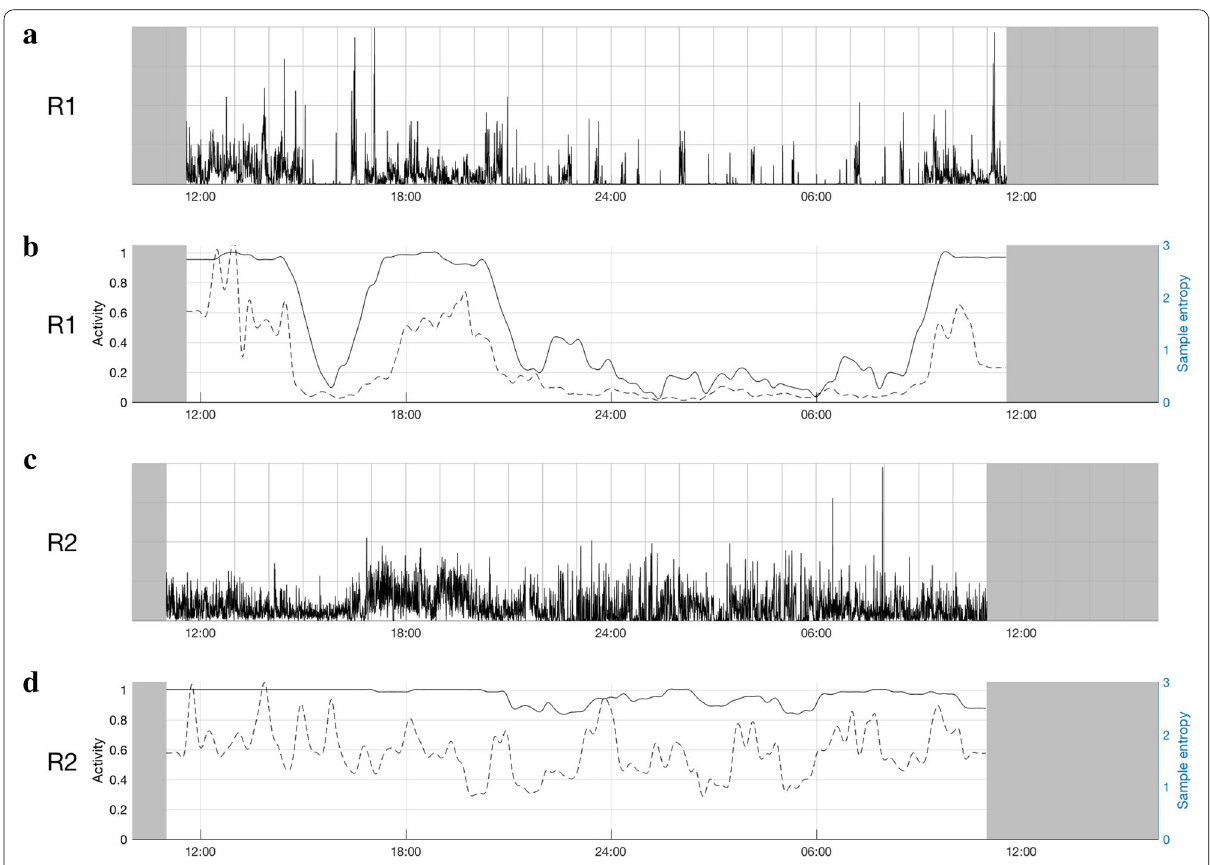
Fig. 3 Actigraphy data for two admissions due to depression and mania (case 3). a , b Represent the first recording (R1) and c , d the second recording (R2). Time of day is shown at the bottom of each chart (24‑h clock). Light grey parts at the beginning and end of each chart represent non‑monitoring time; a , c are 24‑h actograms: activity counts are shown as black, vertical lines on a scale from 0 to 500 counts. One square in the grid represents 1 h on a horizontal axis and 125 counts on a vertical axis. b , d The ratio between rest and activity as the fully drawn line (left axis) and sample entropy as the dotted line (right